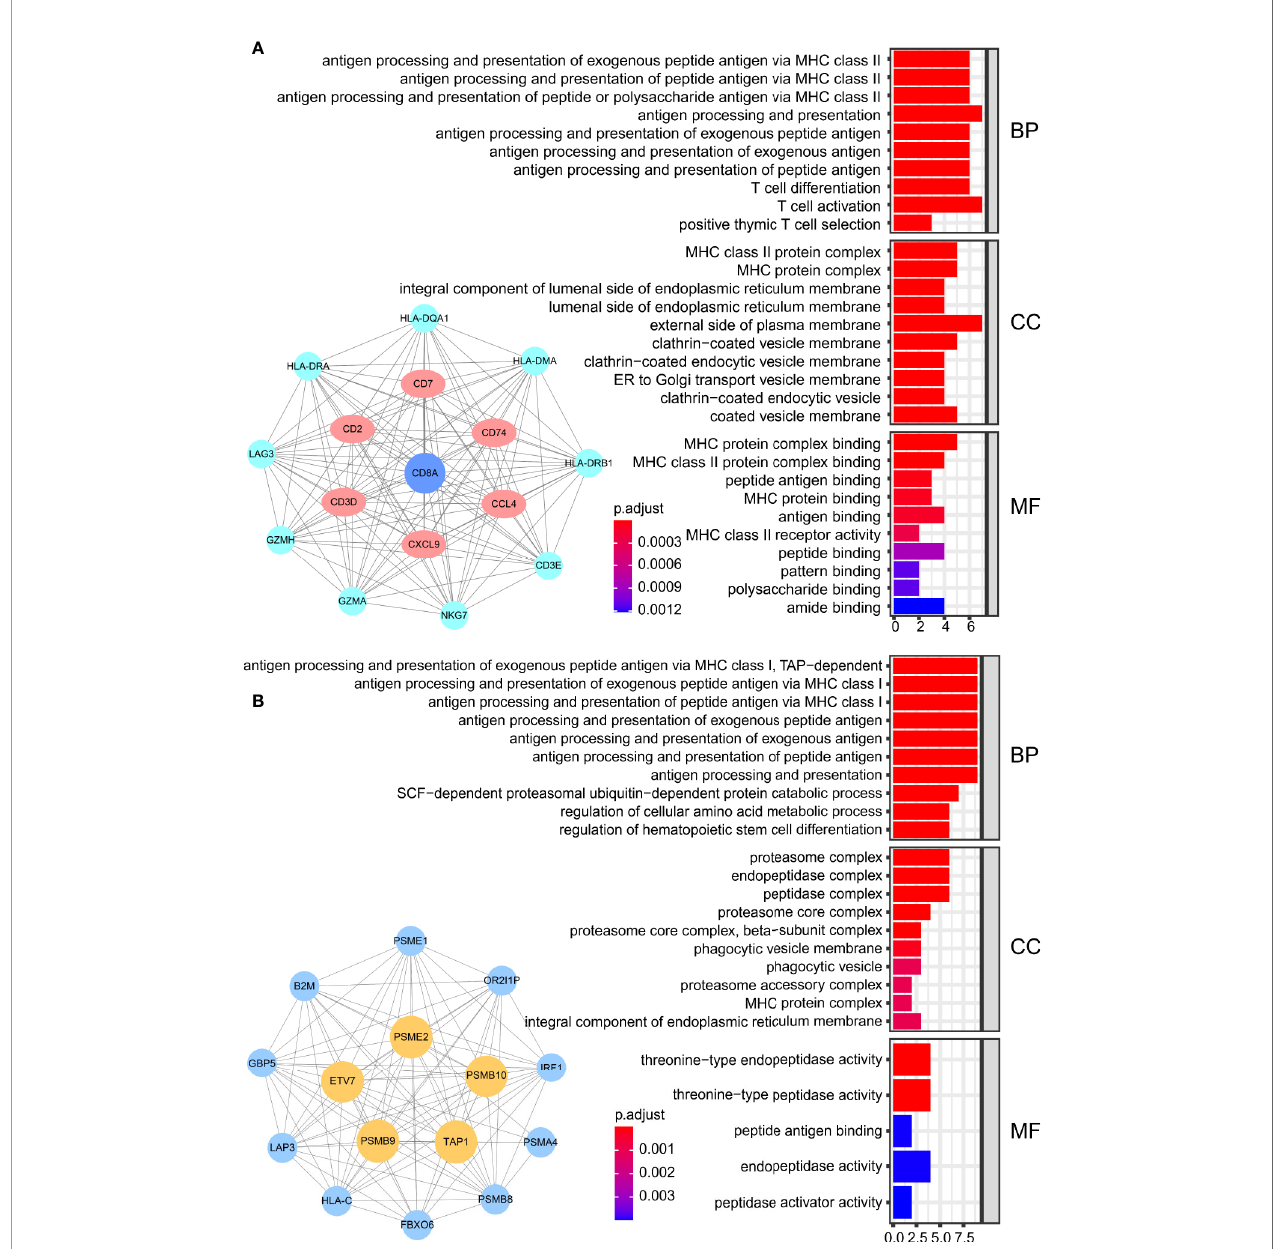
FIGURE 4 | The result of GO analysis. (A) The genes in the blue module were enriched in antigen processing and presentation via MHC class II molecules. (B) The genes in green-yellow module were enriched in antigen processing and presentation via MHC class I molecules.